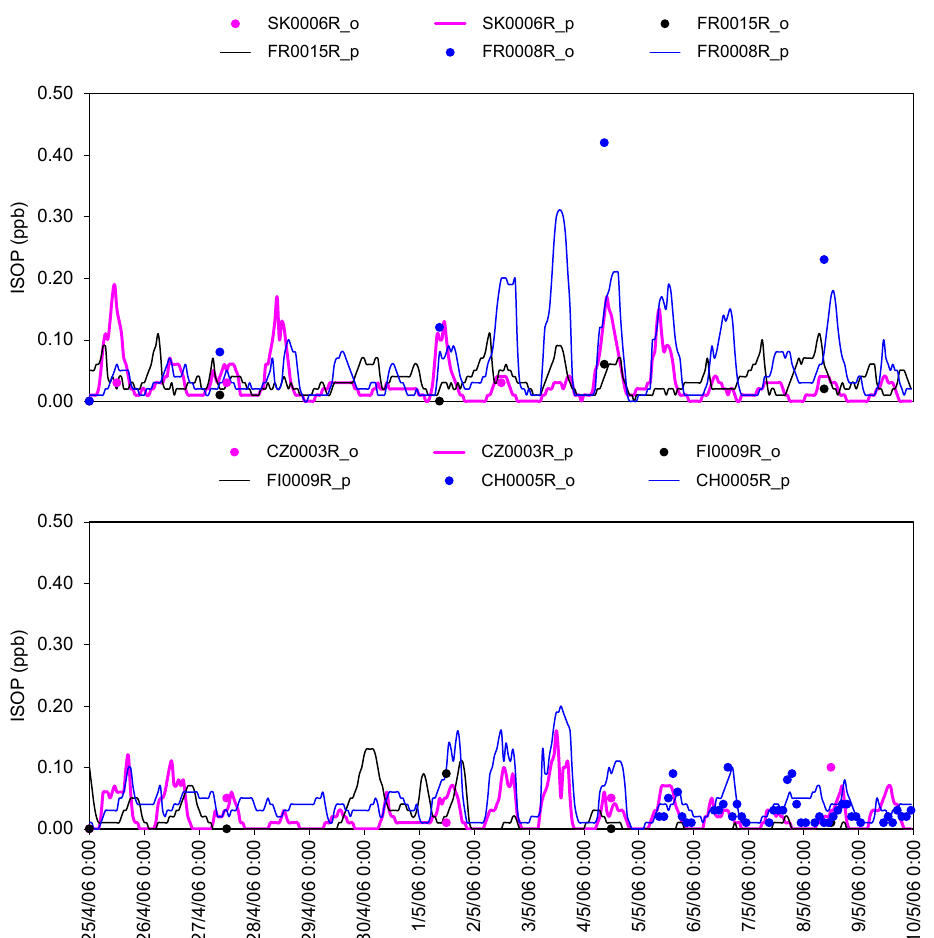
Fig. 2. Time series of predicted (lines) and observed (symbols) surface isoprene concentrations (ppb) during the simulation period at six stations of the EMEP network. The location of the stations is presented in Fig. 1 (upper left plot).